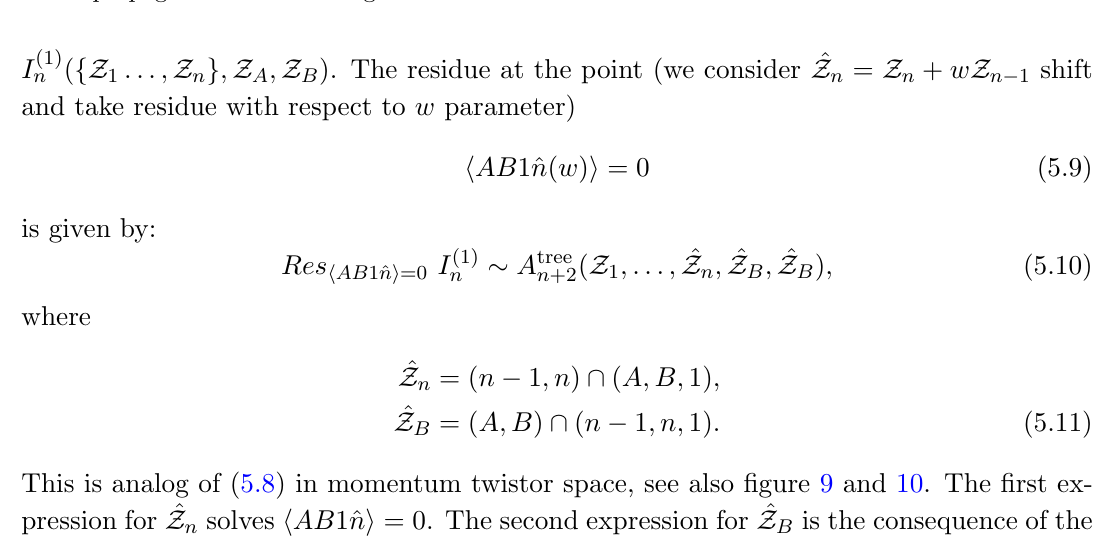
Figure 9 . Evaluation of residue in the pole (cut) of eikonla loop propagator. Red arrow indicates which propagator we are